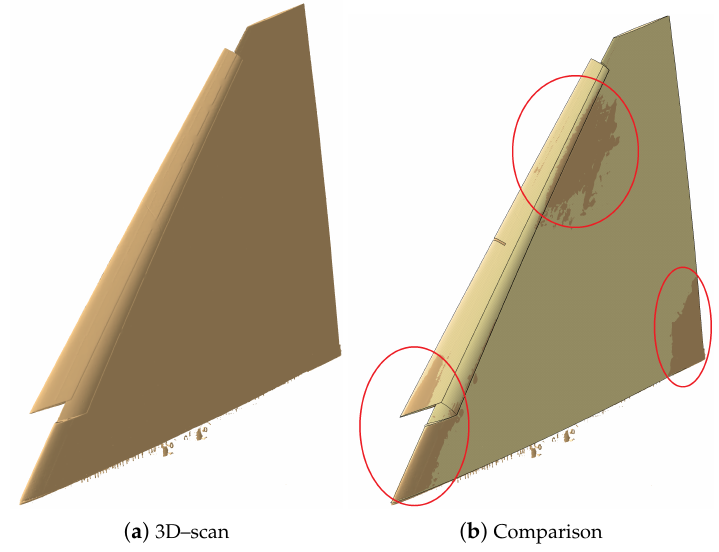
Figure 9. Comparison of the 3D-scanned and the CAD